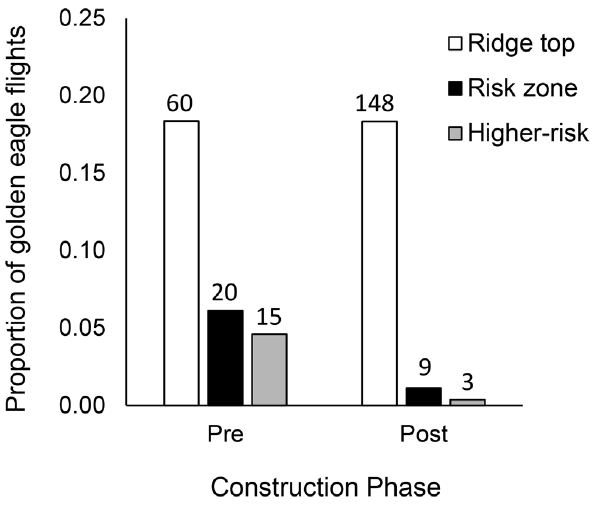
Figure 2. Proportion of golden eagle risk zone and higher-risk crosses. Proportion of golden eagles observed in the study area that flew over the ridge-top area (100 m buffer around proposed turbine string), at heights considered to be within the turbine risk zone ( # 150 m above ground), or made a higher-risk flight into the risk zone (risk zone crosses that occurred at winds above turbine cut-in speed [6.8 km/h]) during pre-construction versus post-construction years. Values above bars represent sample